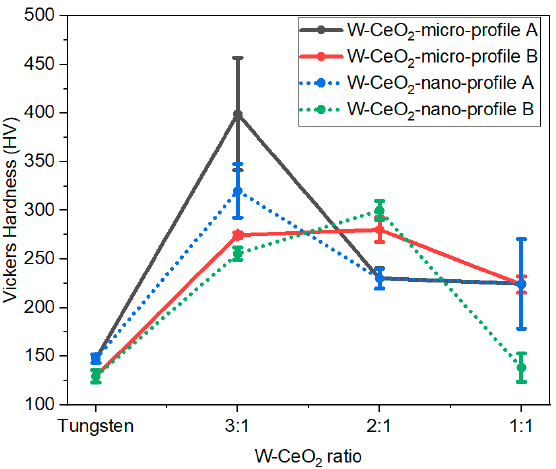
Figure 6. Vickers hardness values for all consolidated specimens. Increasing the CeO 2 content is observed to correlate with decreases in the hardness values.